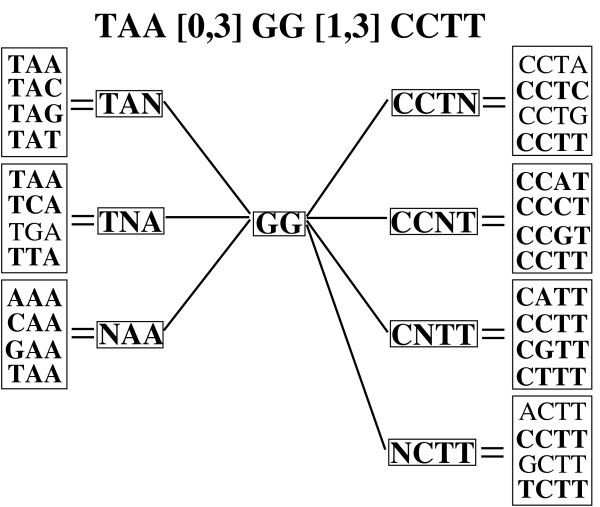
Aggregate Neighbors.